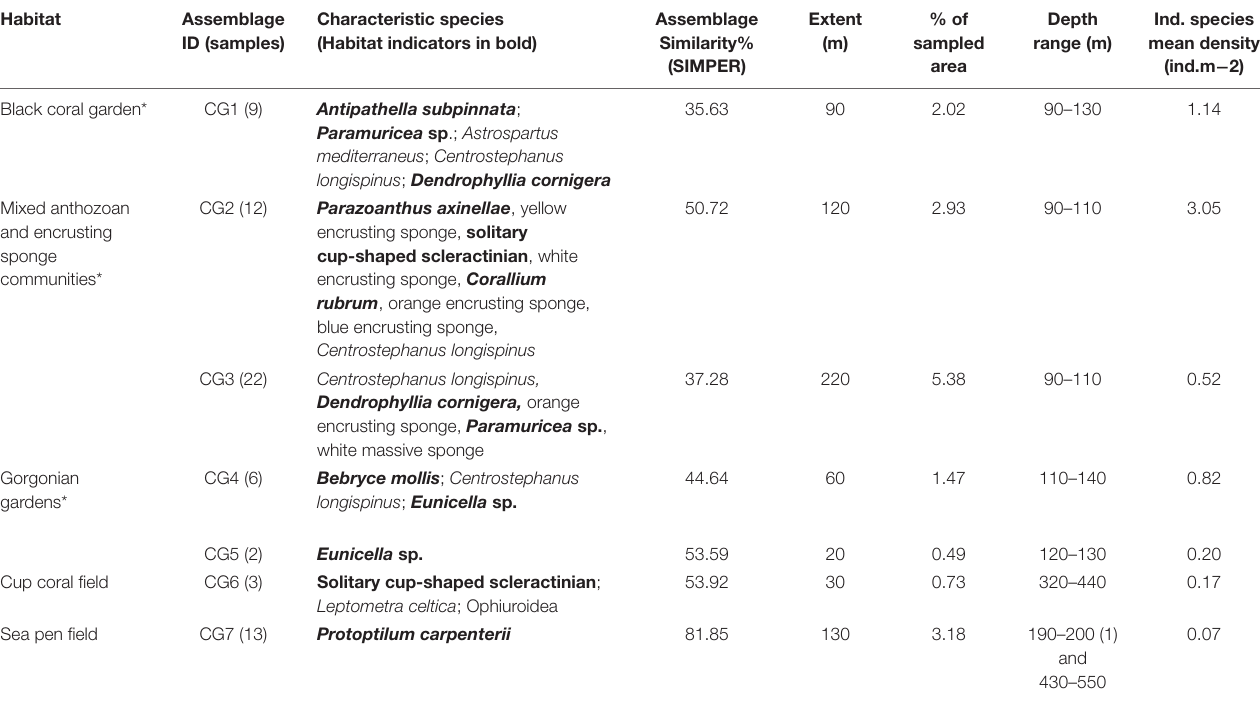
TABLE 3 | Assemblages characterized and dominated by corals in the São Vicente Submarine Canyon. Habitat Assemblage Characteristic species ID (samples) (Habitat indicators in bold)